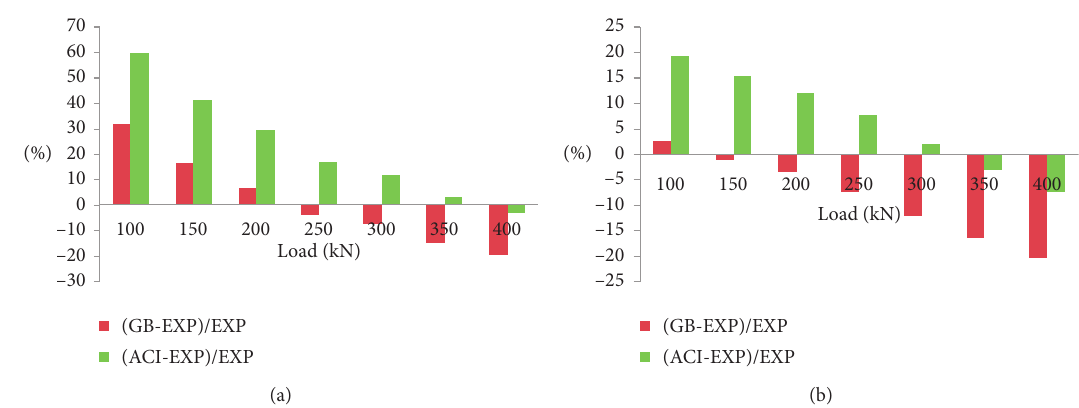
Figure 17: Comparison of experimental and code predicted beam deflection at different loads. Table 5: Comparison of experimental and ACI predicted maximum crack width. Specimen